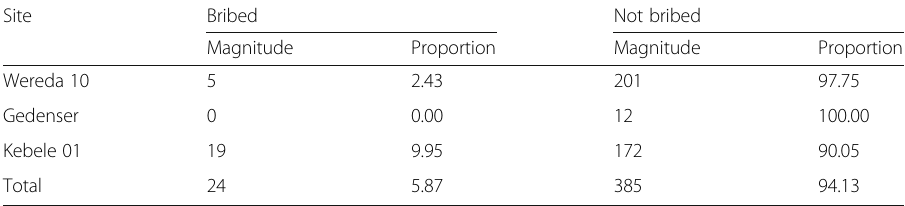
Table 9 Unemployment and unfair competition